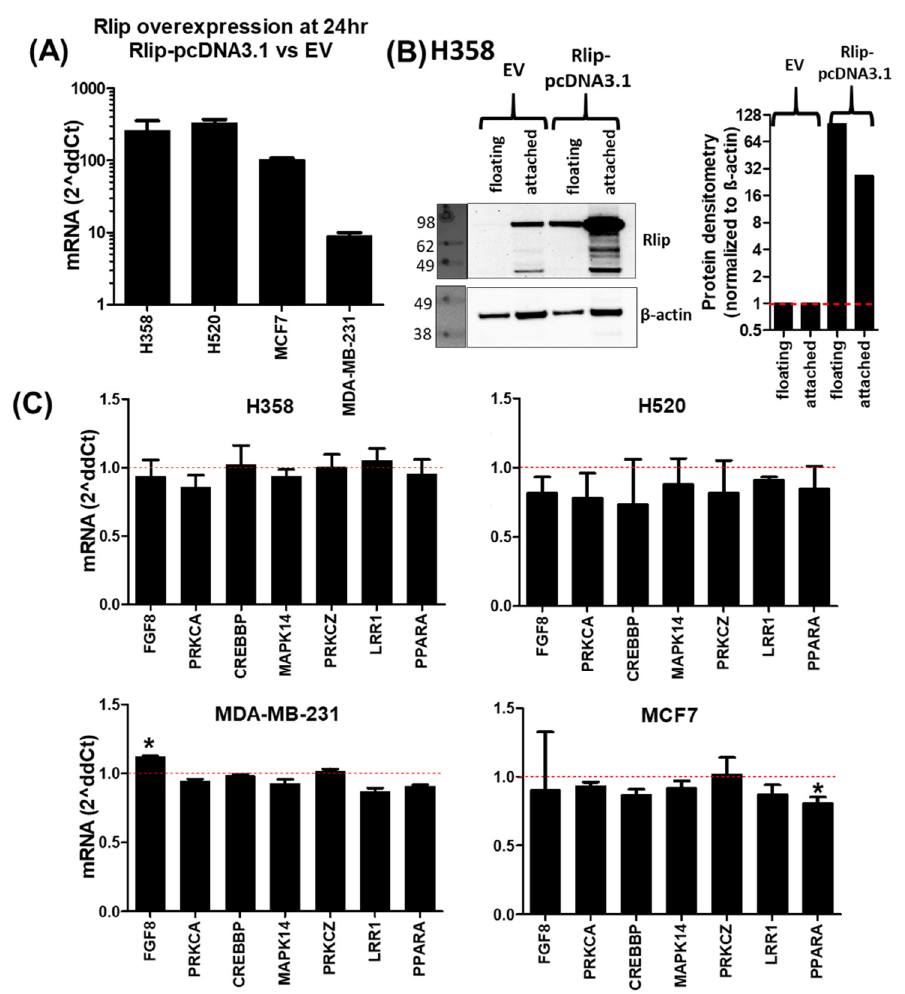
Figure 2. Rlip overexpression minimally alters transcription. Cells were collected 24 h following transfection with a pcDNA3.1-based Rlip overexpression plasmid or the empty vector (EV). ( A ) RALBP1 mRNA was increased 10-fold to 300-fold with the Rlip-pcDNA3.1 plasmid relative to the EV. ( B ) Western blot in H358, confirming that increased RALBP1 mRNA resulted in increased Rlip protein in both attached and floating cells. Densitometric analysis showed that Rlip protein was increased 27-fold in attached cells and 102-fold in floating cells at 24 h. Uncropped Western Blots and densitometry can be found at Figure S6 ( C ) Rlip overexpression resulted in relatively minor expression changes and did not result in a simple reversal of the pattern seen with Rlip knockdown by Rlip-LNA. Asterisks ( * ) indicate p < 0.05 by Student’s t- test when comparing mRNA expression from each Rlip-pcDNA3.1 treatment to its corresponding EV control treatment (defined as 1 and indicated by the red dotted lines). Error bars indicate SEM ( n = 3).